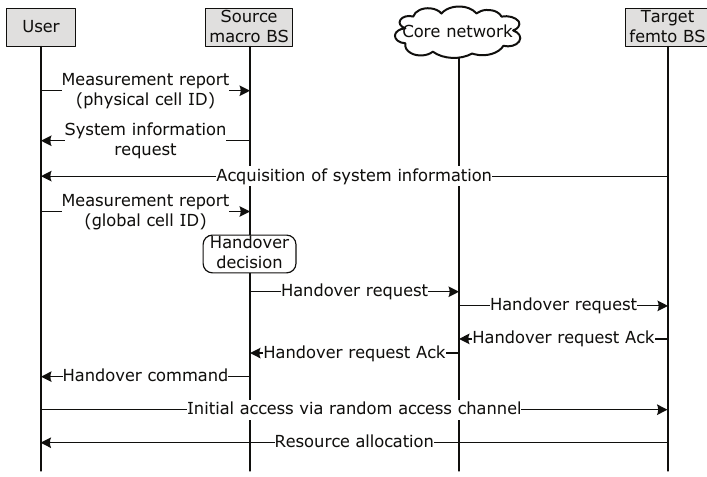
Figure 2. Procedure of a handover from a macrocell to a